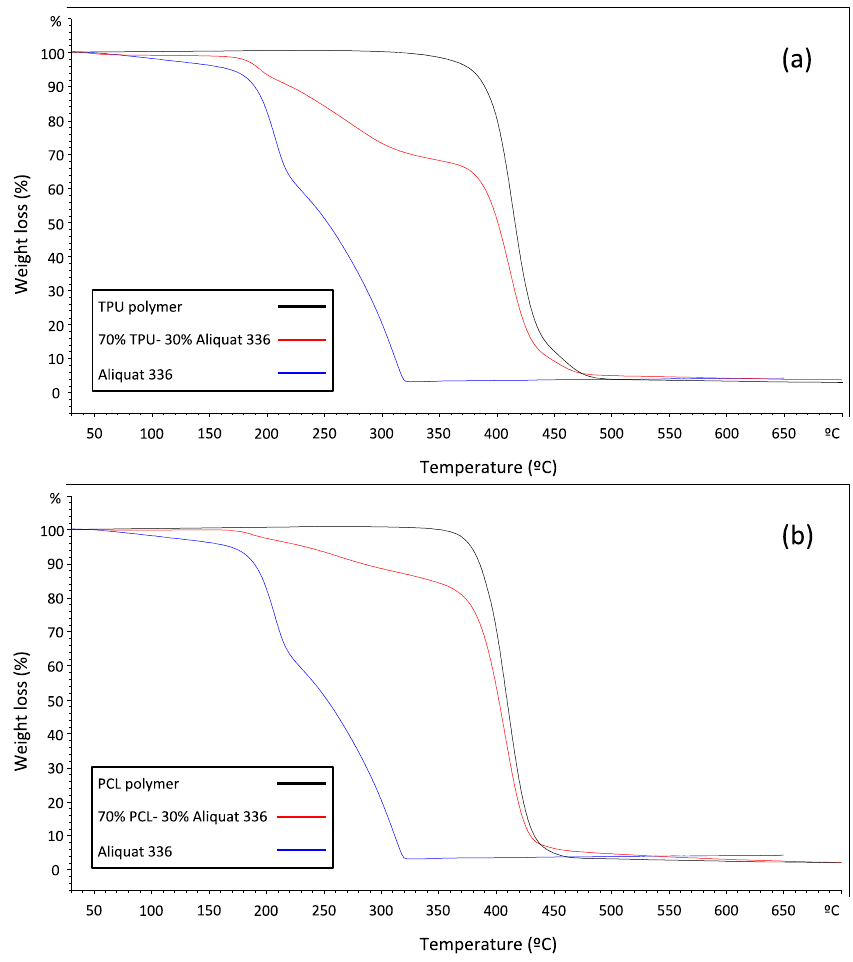
Figure 1. TGA curves for 70% TPU–30% Aliquat 336 ( a ) and 70% PCL–30% Aliquat 336 ( b ).